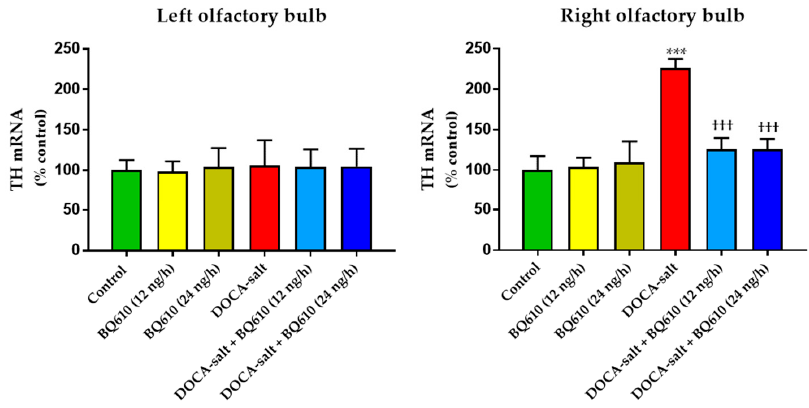
Figure 5. Tyrosine hydroxylase mRNA expression in the left and right olfactory bulb of normotensive and DOCA-salt hypertensive rats. TH mRNA was assessed by real time PCR as detailed in Materials and Methods. Results are expressed as percentage of control ± SEM (% control). *** p < 0.001 vs. control; ††† p < 0.001 vs. DOCA-salt. Number of animals: 4 in all experimental groups.